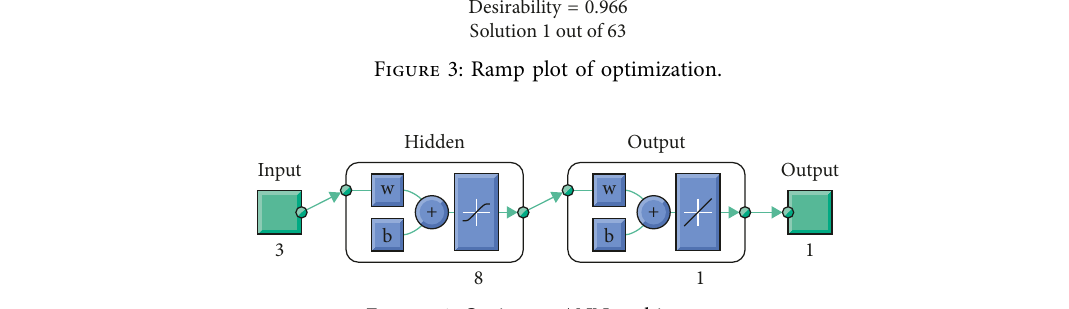
Figure 4: Optimum ANN architecture.